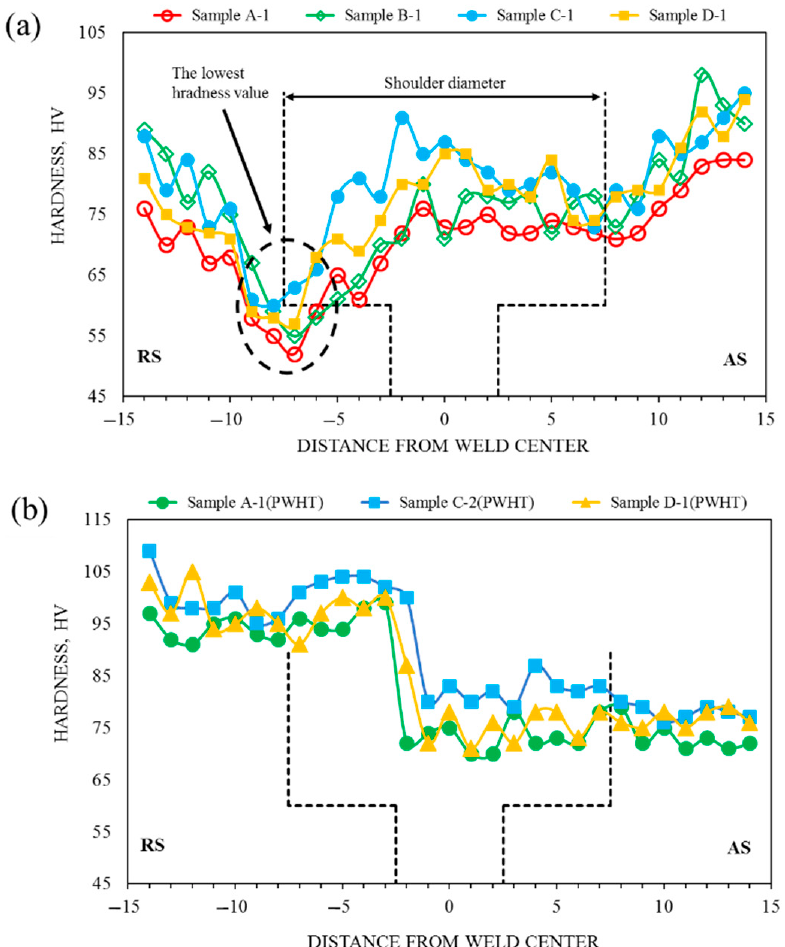
Figure 8. Hardness profile of the dissimilar joint of Al5083-Al6061(T6); ( a ) as-welded and ( b ) PWHTed conditions. The black dotted line is the tool pin profile.